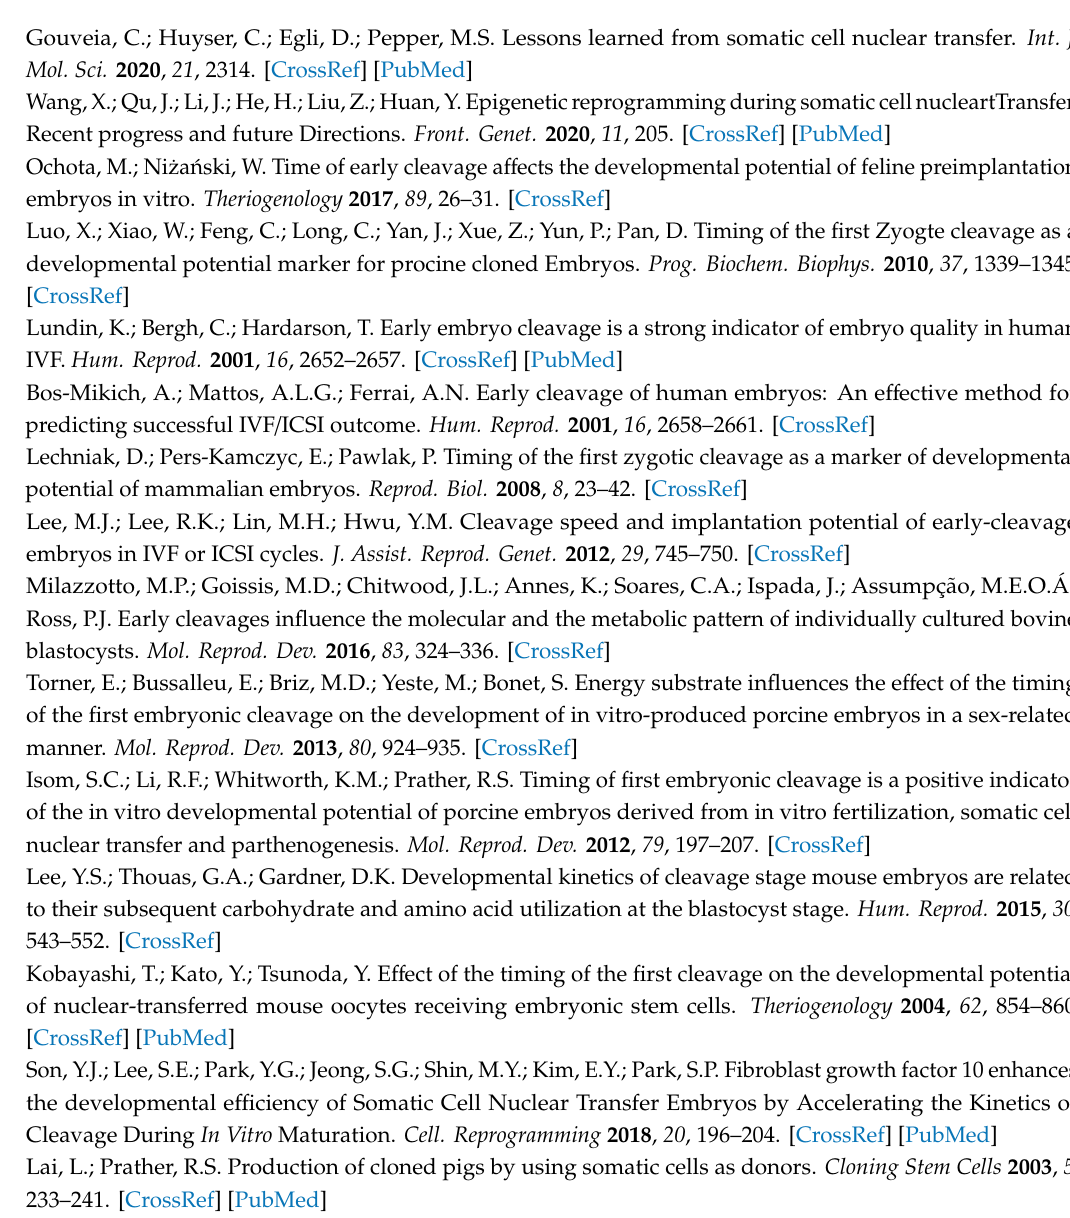
Figure S1: Plot of PCA loading. Table S1: QC summary. Table S2: Mapping statistics. Table S3: All gene FPKM values. Table S4: Retained genes that fall within the top and bottom 1% fractions of the PC1 and PC2 loadings’